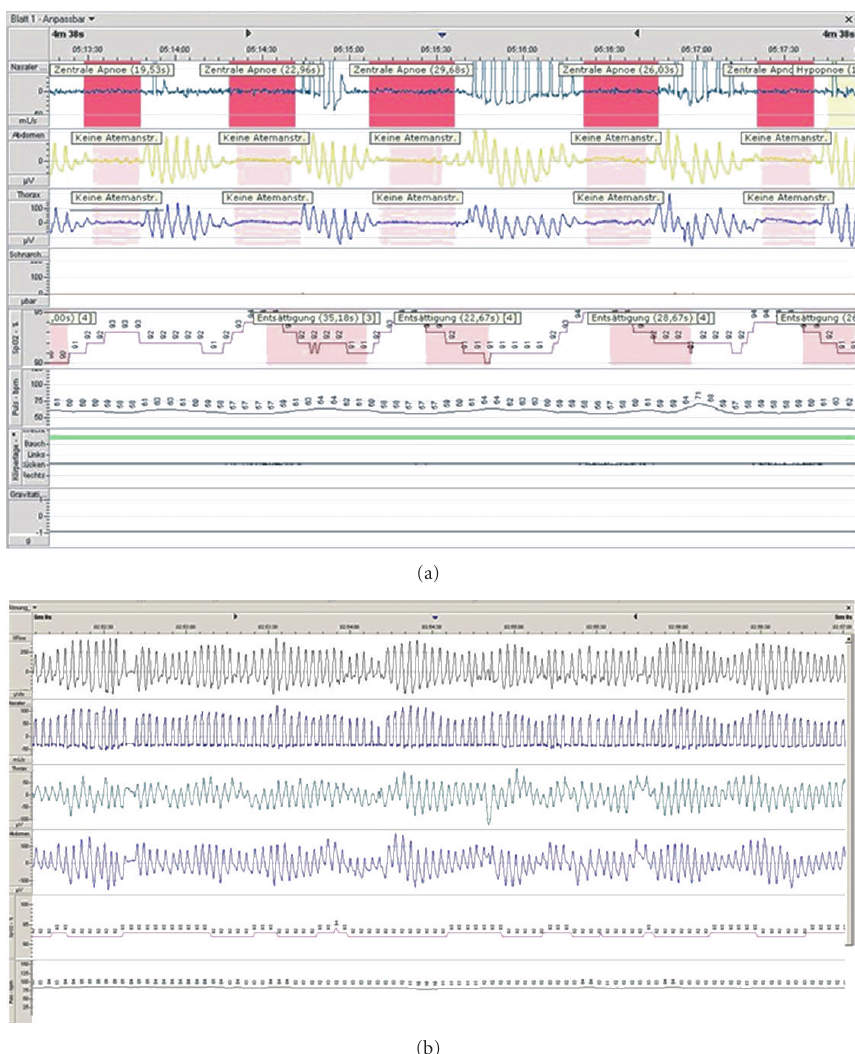
Figure 1: Respiratory analysis of a patient before (a) and after (b) aortic valve replacement. (a) Typical breathing in CSA without respiration e ff orts (nasal airflow, abdominal and thoracic breathing e ff orts, oxygen saturation, and heart rate are shown), (b) Only mild undulating nocturnal